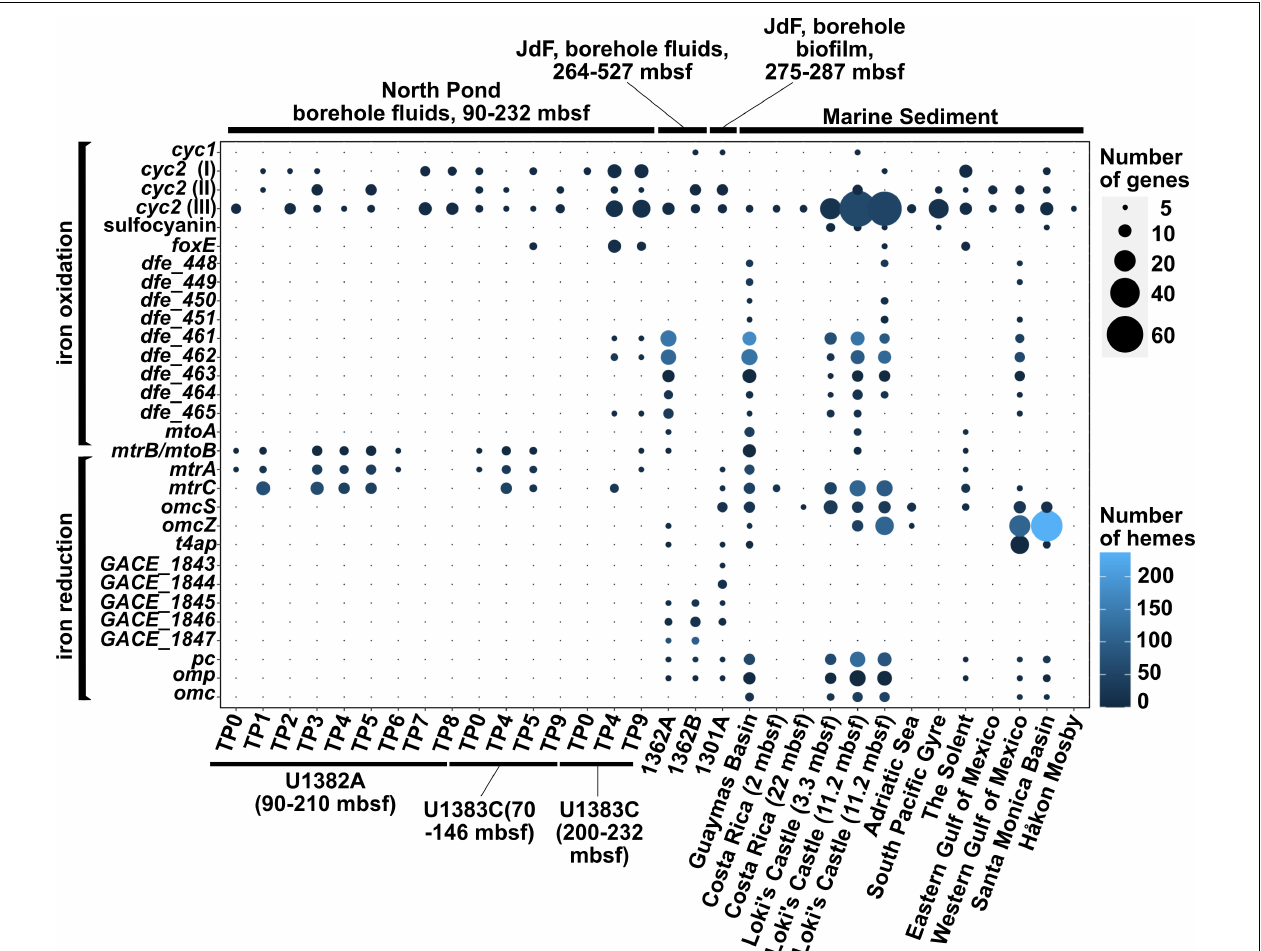
FIGURE 1 | Distribution of iron redox genes among the 32 metagenomes in which potential for iron reduction or oxidation was detected. The gene mtrB / mtoB is deliberately placed in between the iron oxidation and iron reduction categories because it encodes a porin that can be part of both the iron reduction ( mtr ) or the iron oxidation ( mto )